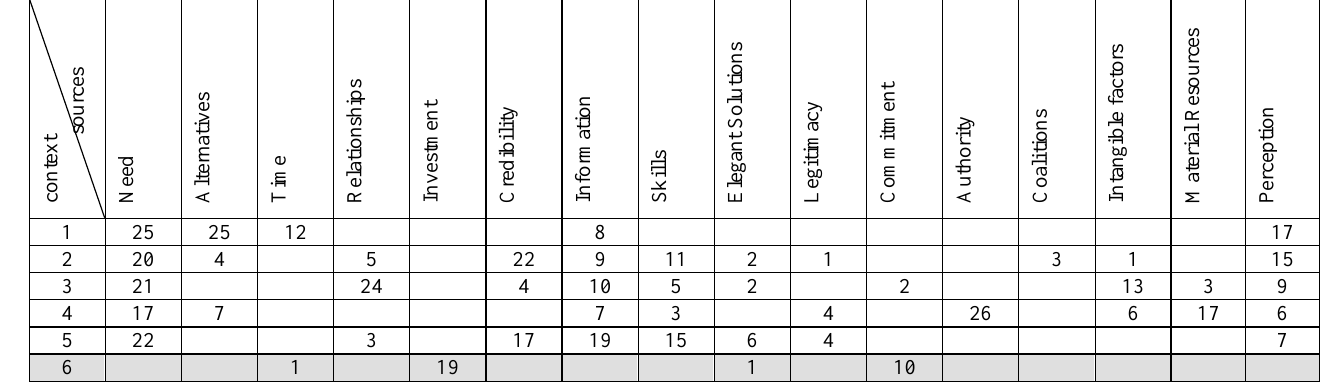
Table 1: Sources of power in different negotiation